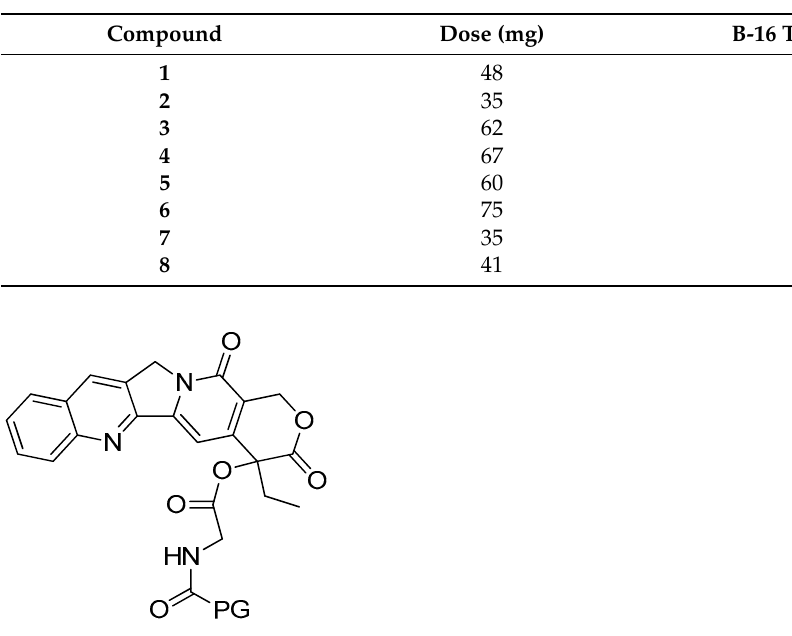
Figure 4. Poly-R-(L-glutamic acid)-L-glycine-camptothecin. Table 2. Effects of poly-R-(L-glutamic acid) conjugates of camptothecin on the in vivo growth of subcutaneous B-16 melanomas. TGD: tumour growth delays. ( 1 ) Poly-R-(L-glutamic acid)-camp-